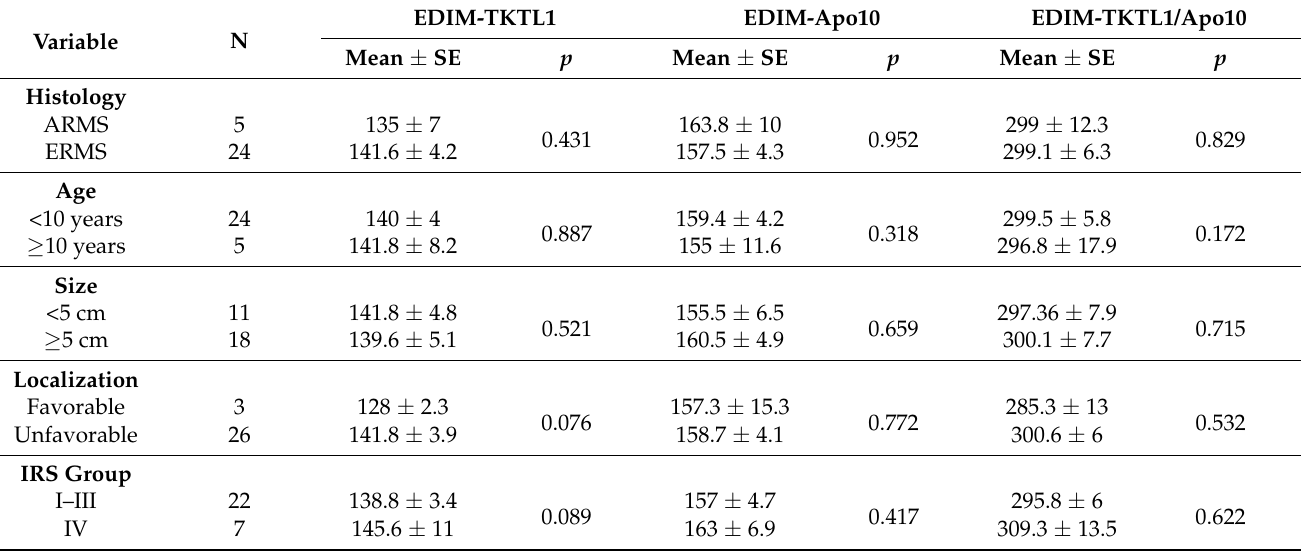
In RMS patients, there was no significant difference of the EDIM-TKTL1, Apo10, and combined TKTL1/Apo10 mean scores depending on histological subtype, IRS stage, tu- mor size, patient’s age, and tumor location, as shown in Table 2. Table 2. EDIM scores depending on risk factors .